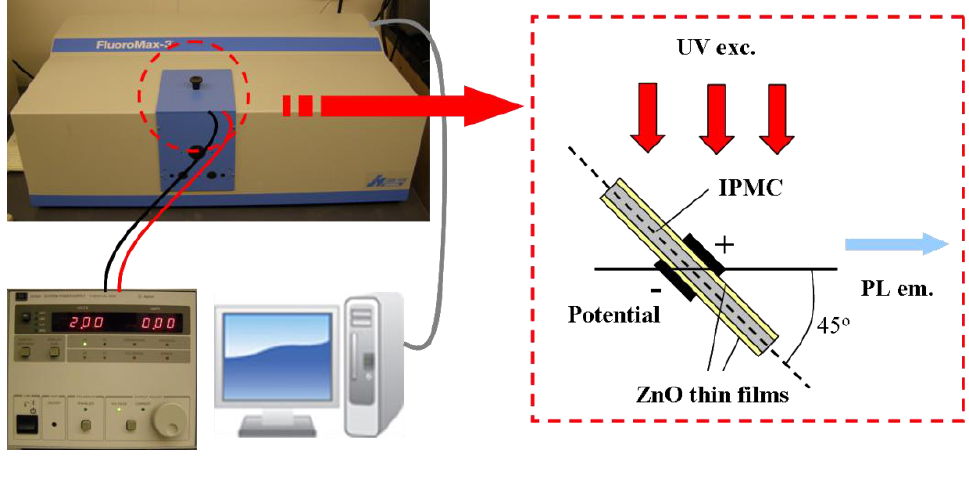
Figure 2. Schematic diagram of the experimental set-up for measuring optical property of IPMZCs. For measurements of PL spectra, the sample is illuminated by UV radiation (280 nm). Spectra are obtained with different potentials from the power supply.